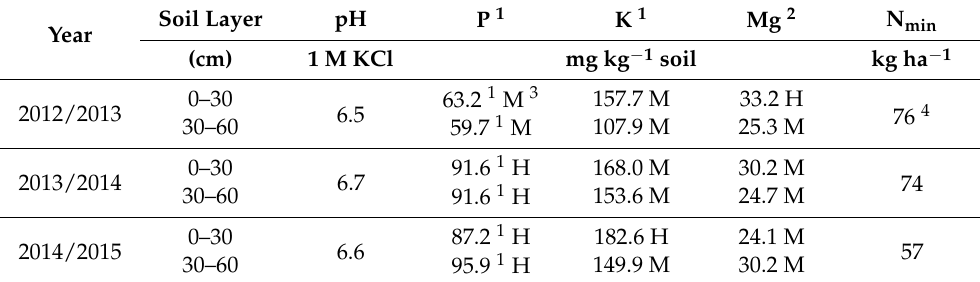
Table 1. Soil characteristics of the experimental plots during 2012–2015 growing